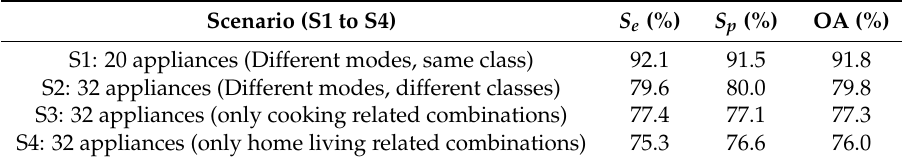
Table 3. Performance evaluation of assignment a class label for different modes in electric appliances. Scenario (S1 to S4) S e